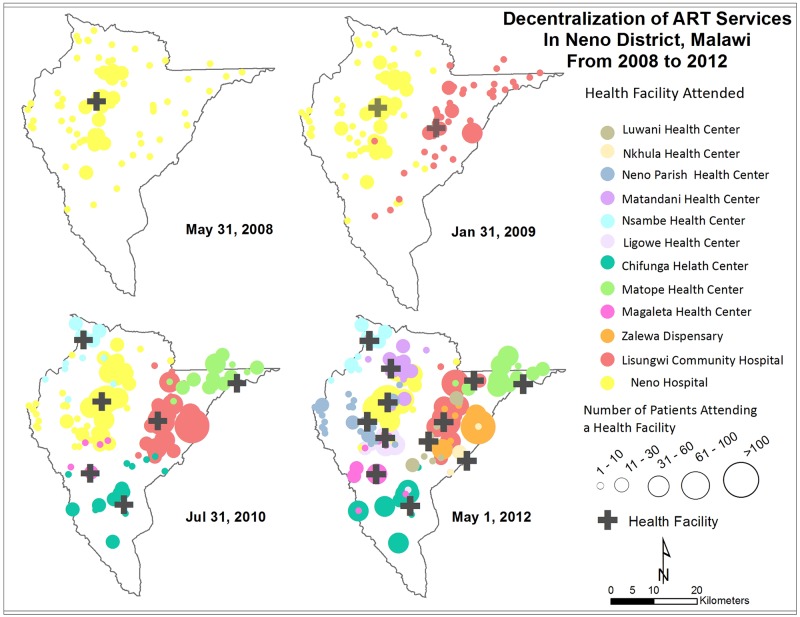
Map of decentralization of ART services from 2008 to 2012.Crosses show location of health facilities. Dots show number of ART patients by home village, color-coded by health facility patient attended. Larger dots indicate a larger number of patients.